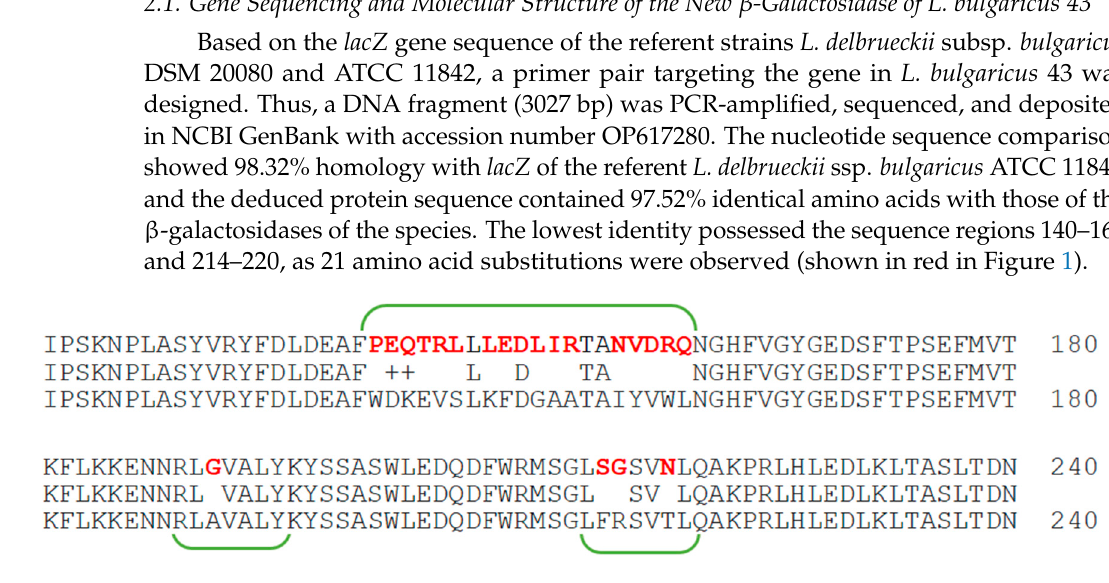
Figure 1. Amino acid sequence comparison of the region possessing the lowest homology with other β -galactosidases of L. bulgaricus . The presented comparison is with the sequence of a well-studied β -galactosidase of L. bulgaricus strain L3 [28], NCBI GenBank number ACE06986.